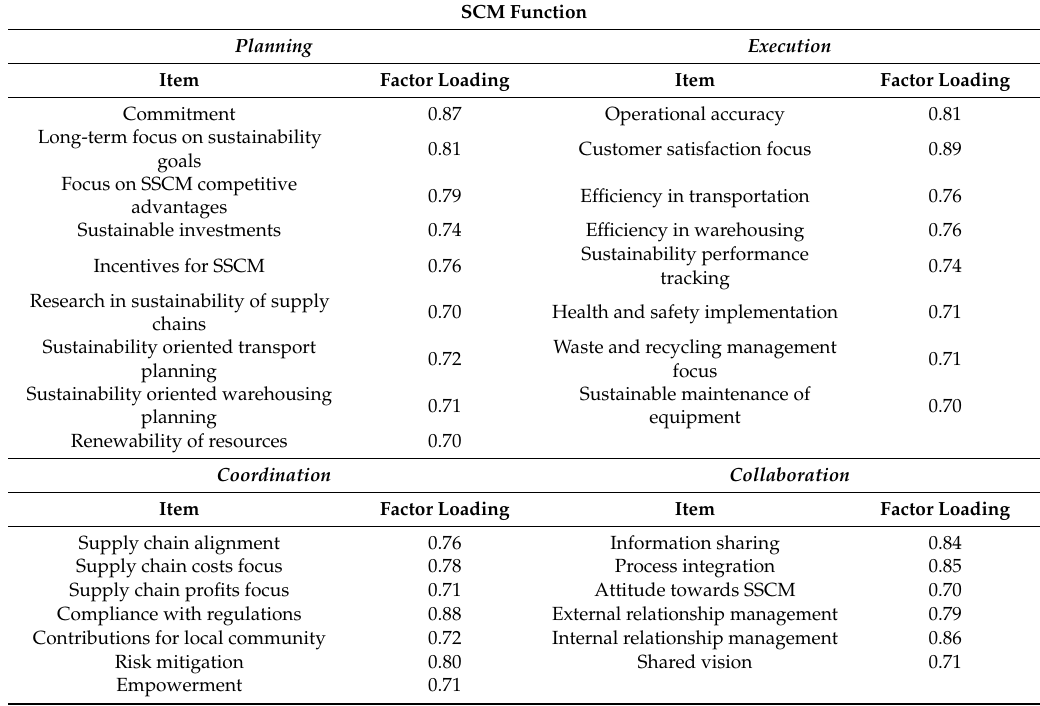
Table 10. Results of EFA for Supply Chain Management (SCM)